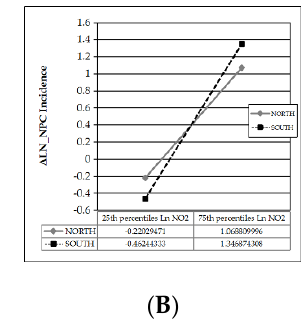
Figure 2. ( A ) Sensitivity of NPC incidence to NO 2 concentration in southern and northern Chinese cities; ( B ) Sensitivity of NPC incidence growth rate to NO 2 concentration in southern and northern Chinese cities.